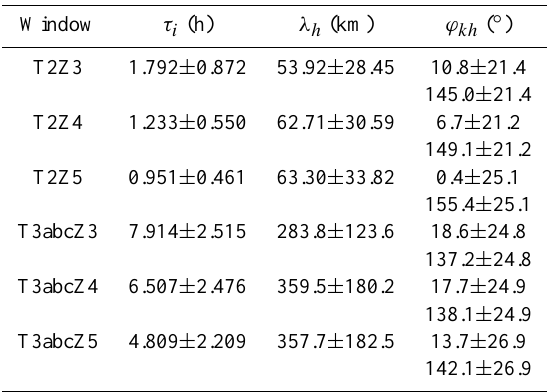
Table 6b. Same as Table 6a except that the BV-period was assumed to be 10min.